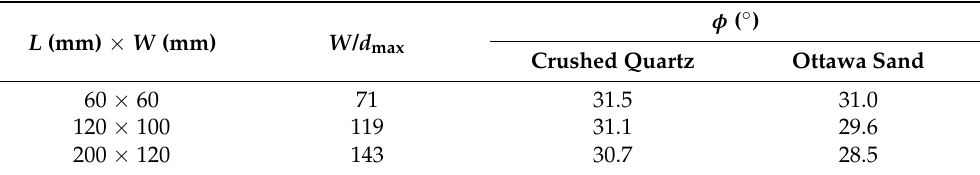
Table 2. Variation of friction angle ( φ ) obtained by Parson (1936) with different specimen sizes through direct shear tests; L is the length of shear